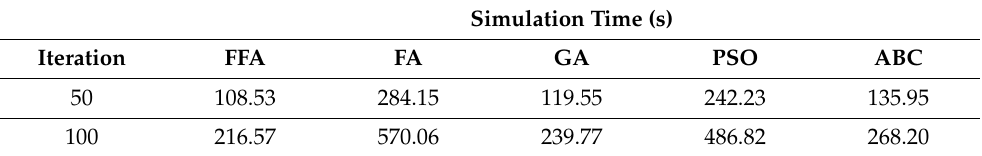
Sensors 2021 , 21 , x FOR PEER REVIEW